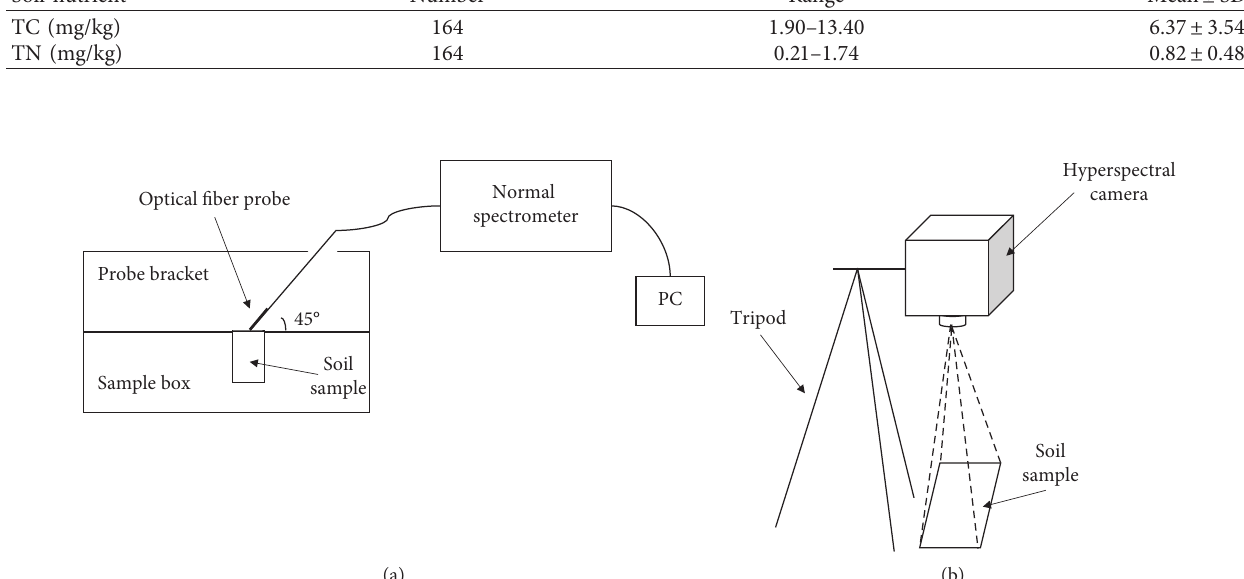
Figure 1: Schematic diagram of soil spectral data measurements. (a) Normal spectrometer; (b) hyperspectral camera.